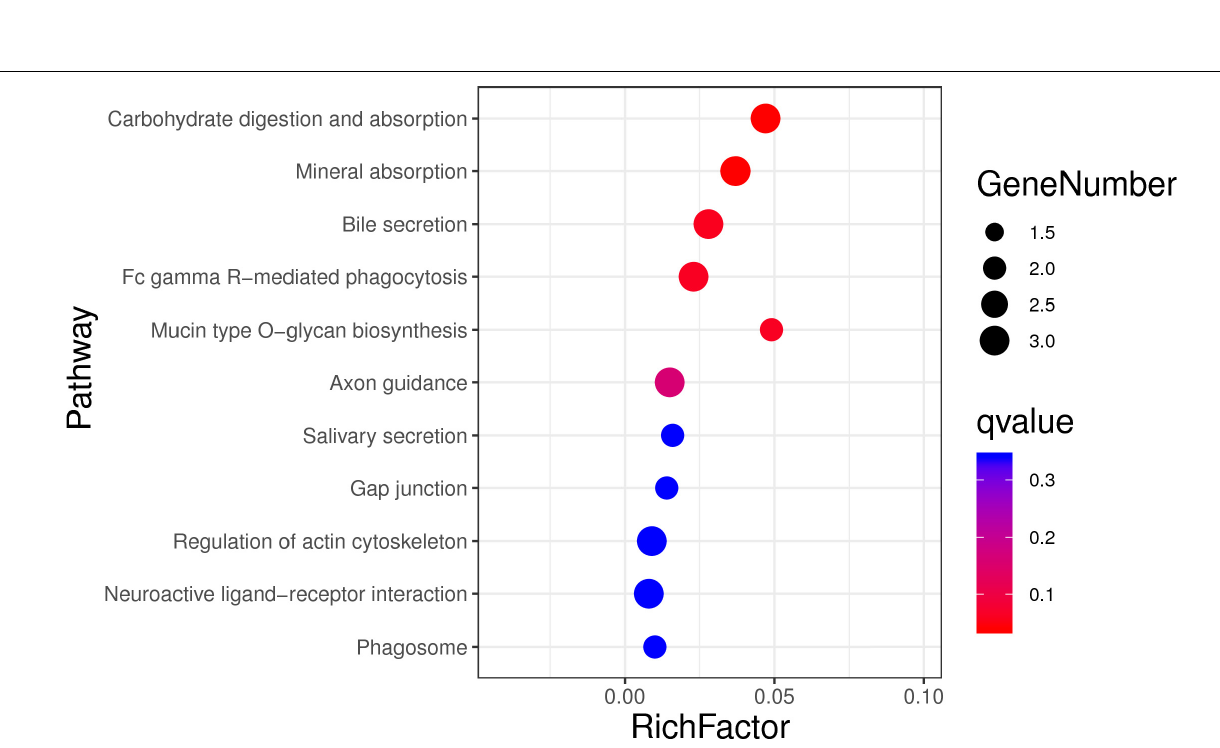
Frontiers in Genetics |